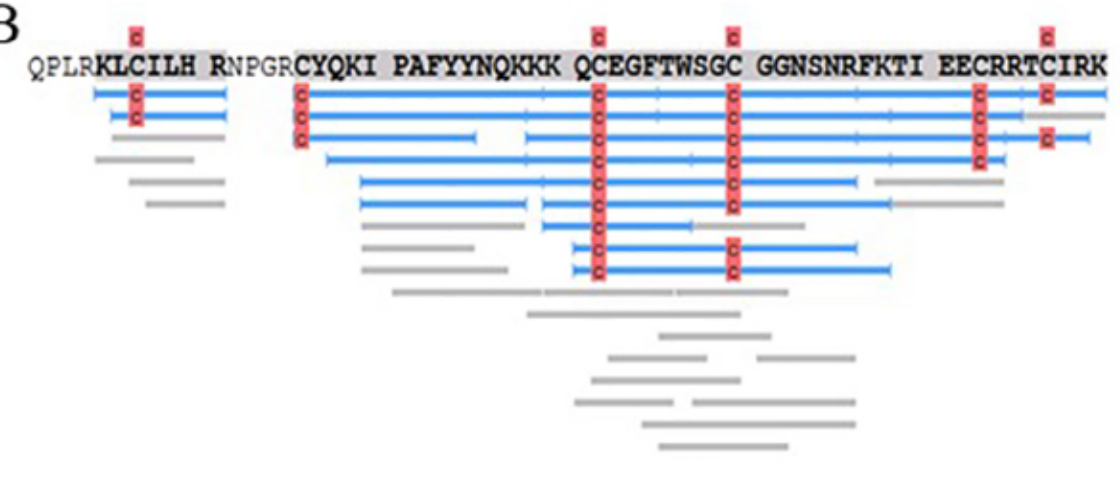
Figure 3. Sequences of the molecule present in the samples named (A) DPSA8 and (B) DPKEN9. The samples were subjected to a tryptic digestion and the LTQ Orbitrap results of the digested fragments were confronted with the database. In blue, peptides found with their respective modifications, in gray, the sequences of the de novo only with 100% of coverage, in red the carbamidomethylationof the cysteine residues. C: carbamidomethylation (+57.02). The results showed that the molecule is a Kunitz-type serine protease inhibitor homolog dendrotoxin I (Uniprot ID